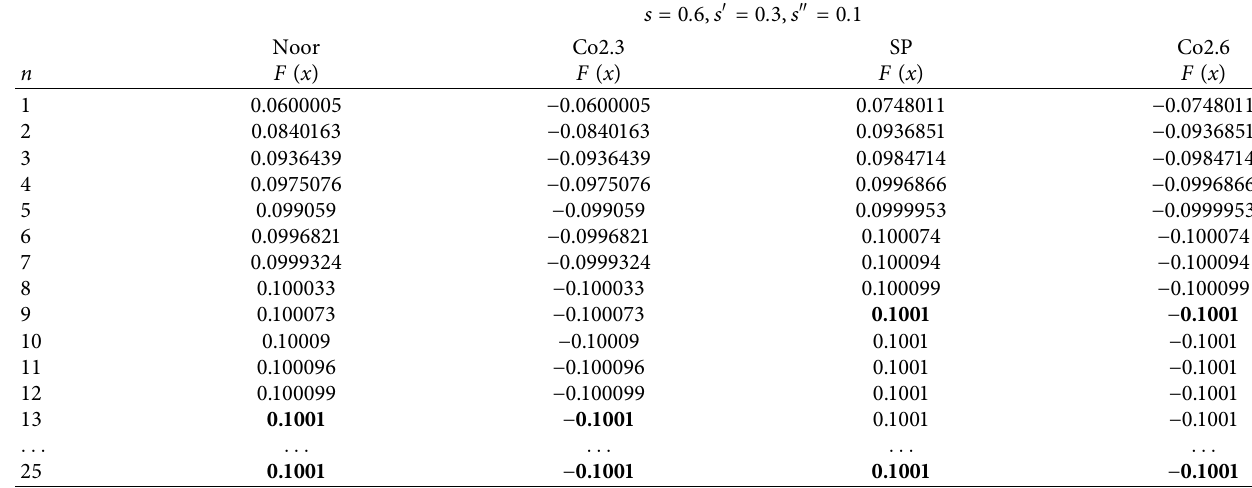
Table 6: Iterations of biquadratic function s � 0 . 6 ,s ′ � 0 . 3 ,s ″ � 0 . 1.